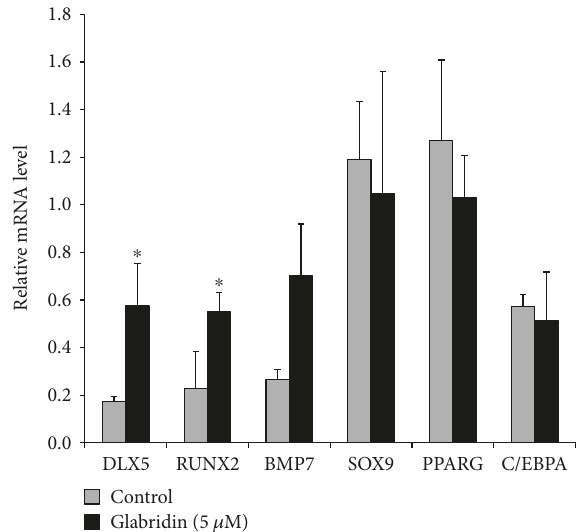
Figure 3: Gene expression in MSCs following glabridin treatment. RT-PCR analysis of osteogenic, chondrogenic, and adipogenic markers was performed in control and glabridin-treated MSCs. Relative mRNA expression levels of trilineage-associated genes in the control and glabridin-treated MSCs. Expression levels relative to GAPDH are shown. The data are expressed as the mean ± SD of three experiments. ∗ P < 0 05 versus untreated